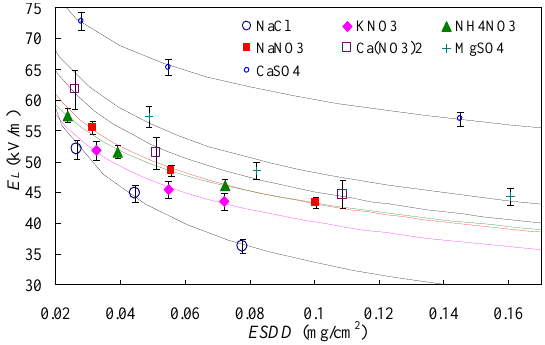
Figure 3. Fitting curves of each soluble constituent using nagative exponent function.